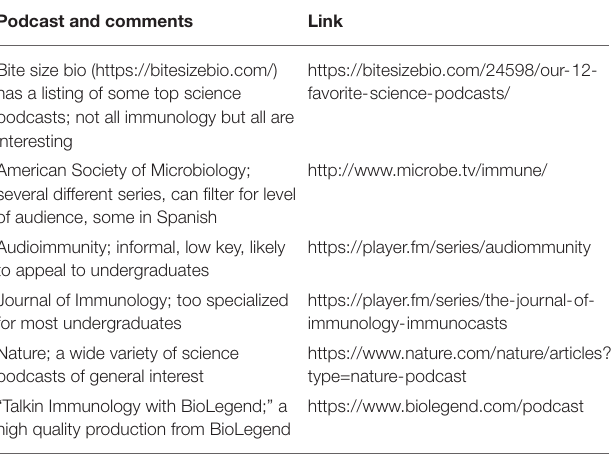
TABLE 3 | Examples of immunology